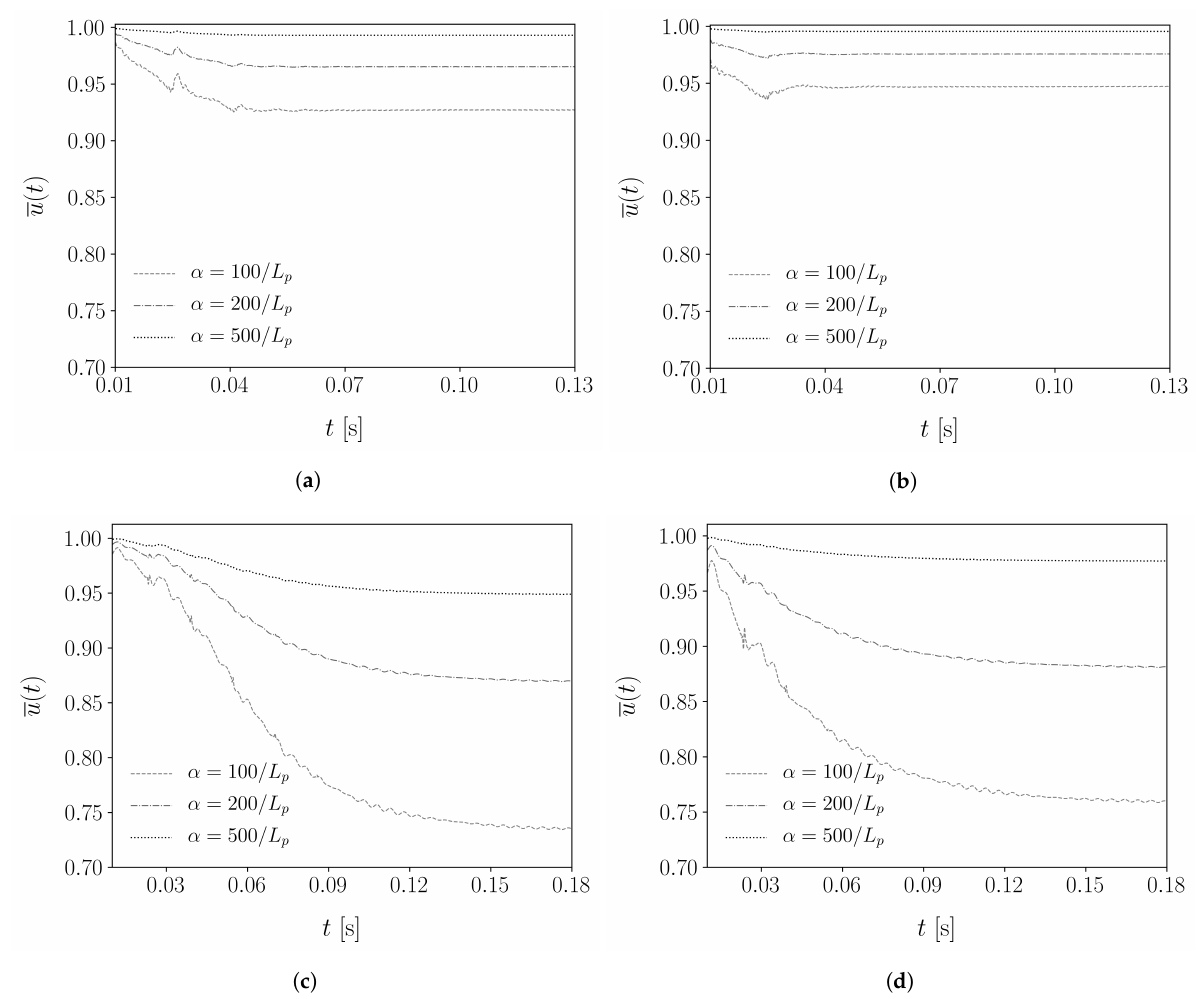
(cid:12) for a pile with (cid:12) α → ∞